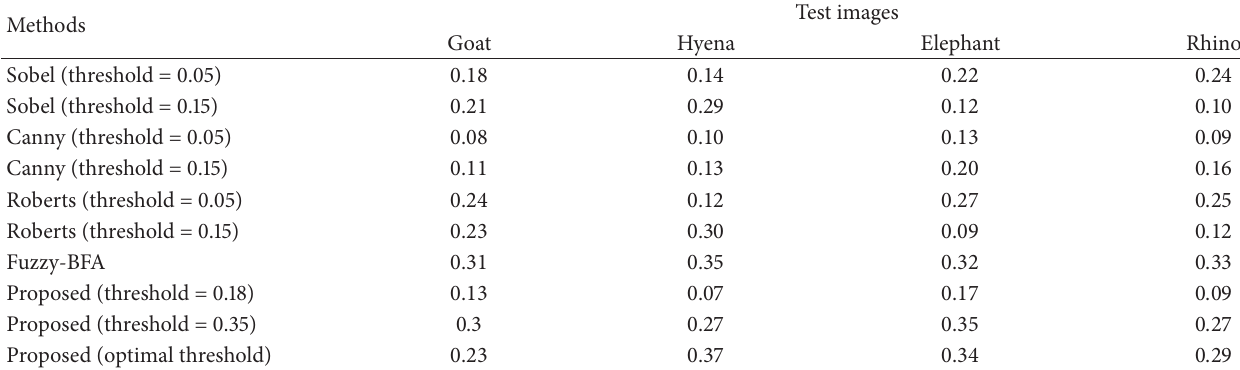
Table 1: 𝑃 values obtained for different test